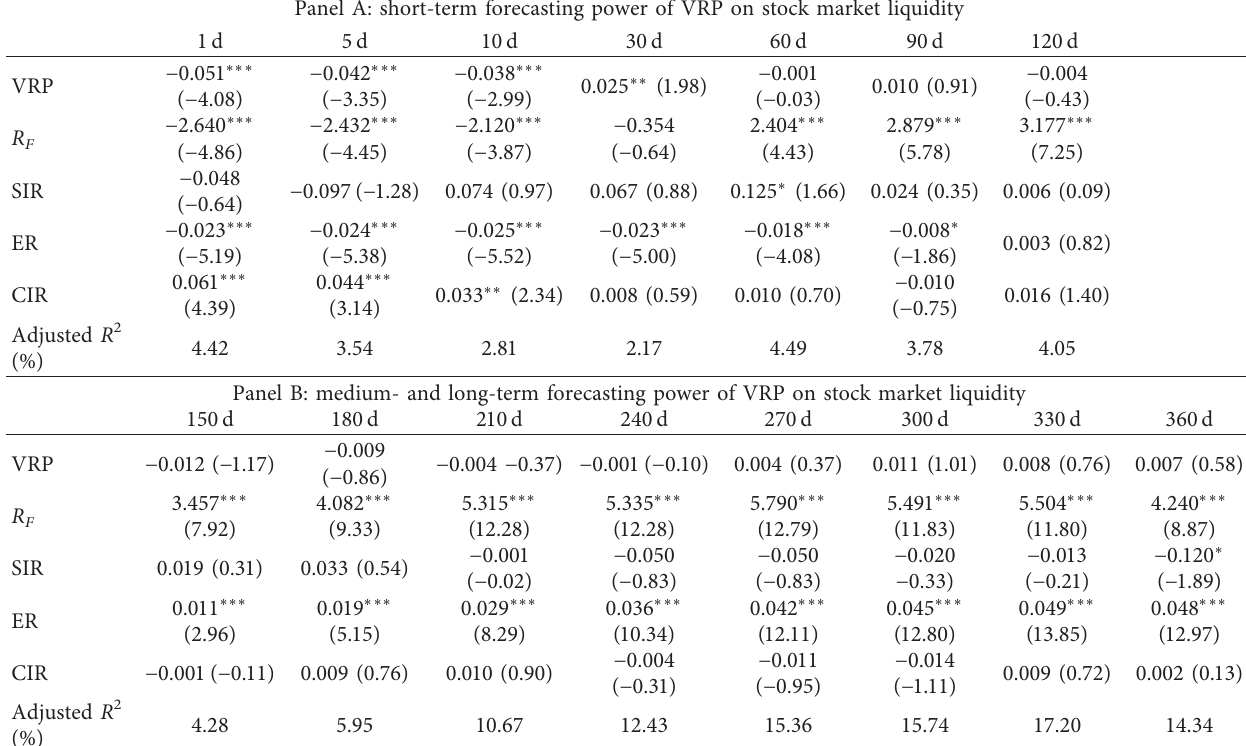
Table 6: Forecasting power of VRP on stock market liquidity.